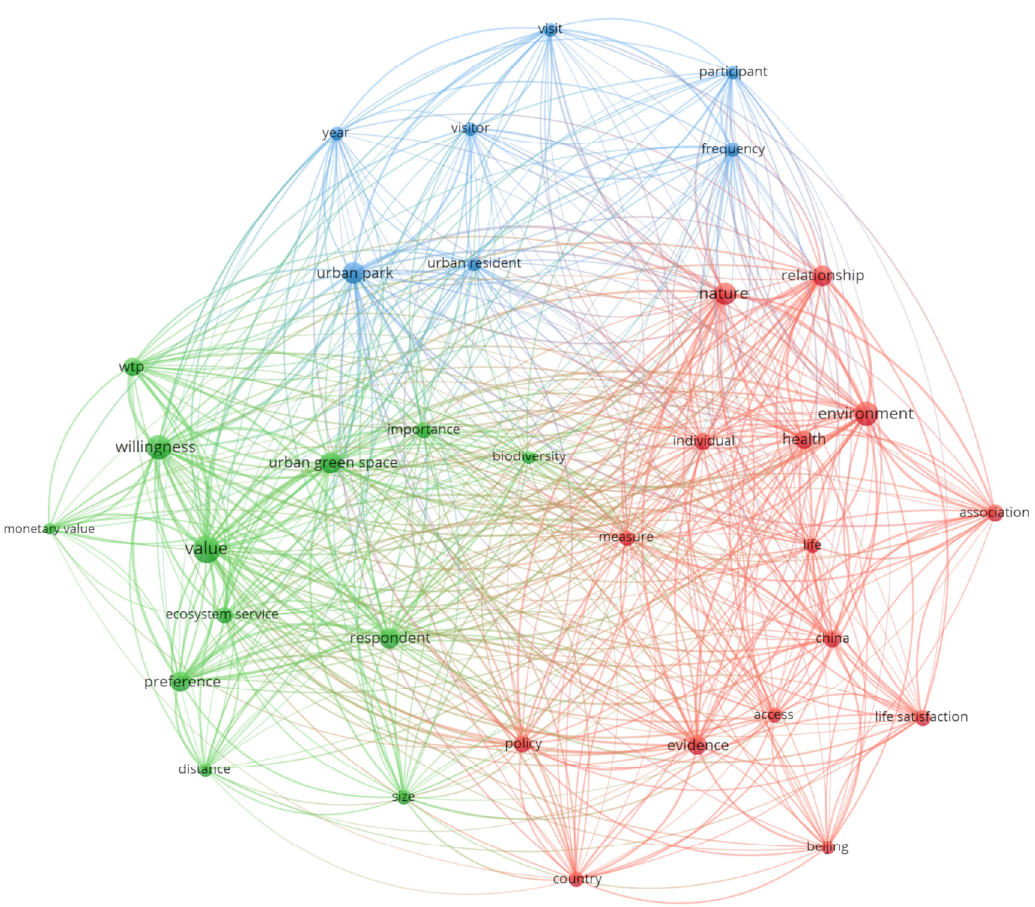
Land 2023 , 12 , x FOR PEER REVIEW Figure 7. Connection network of terms in titles and abstracts (3 clusters). Figure 7. Connection network of terms in titles and abstracts (3 clusters).